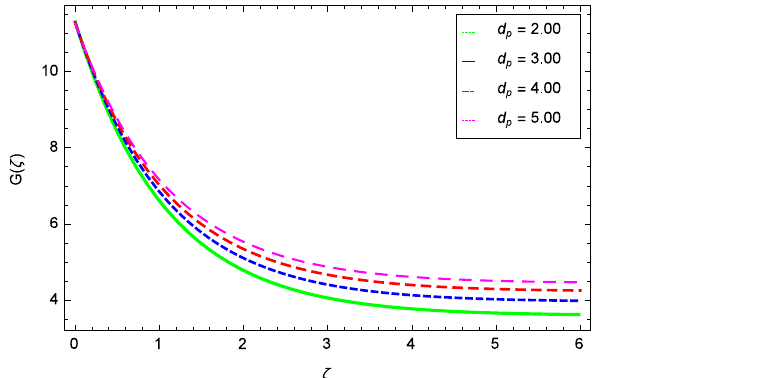
Figure 16. Effect of d p on tangential velocity G (ζ) .